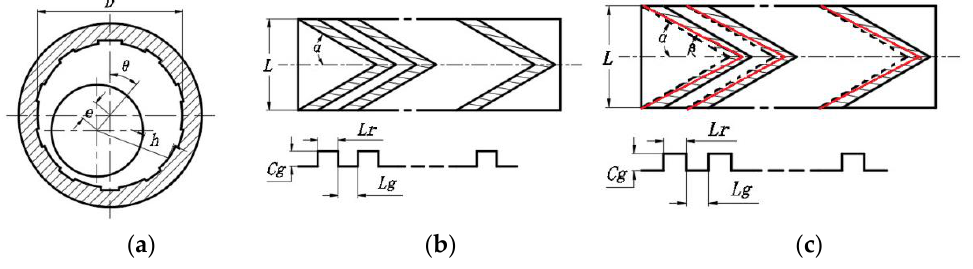
Figure 1. Structure diagram of HGJBs: ( a ) Front view of the bearings ( b ) Constant-width HGJBs ( c ) Convergent HGJBs.